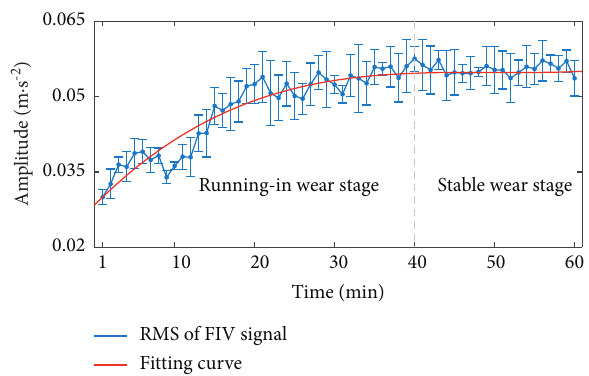
Figure 9: RMS value variation of the extracted periodic FIV signal in the running-in